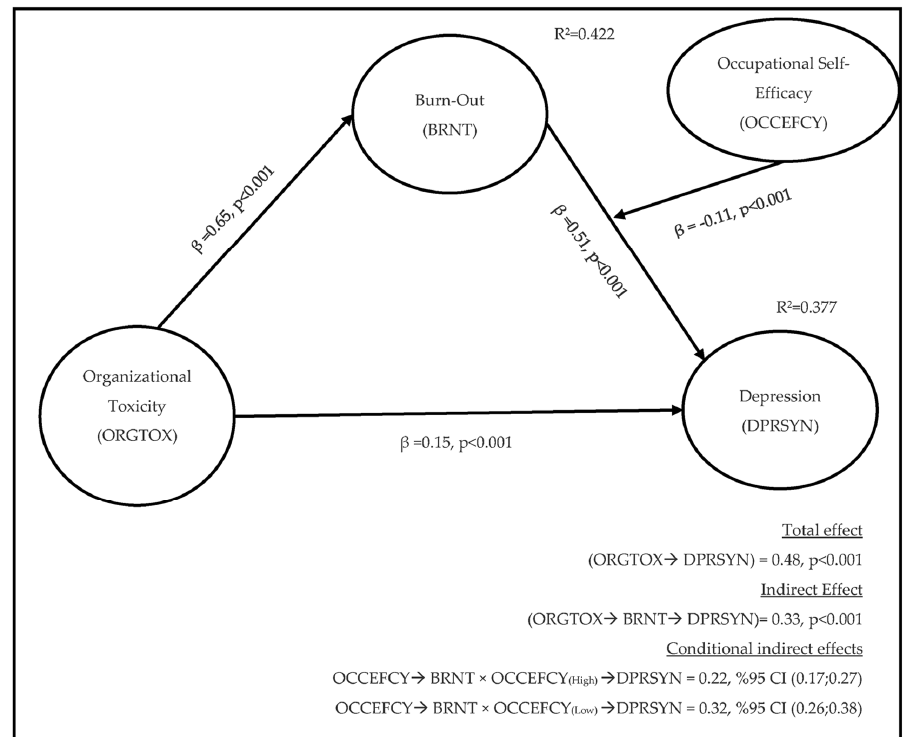
Figure 2. Results of the conceptual model.